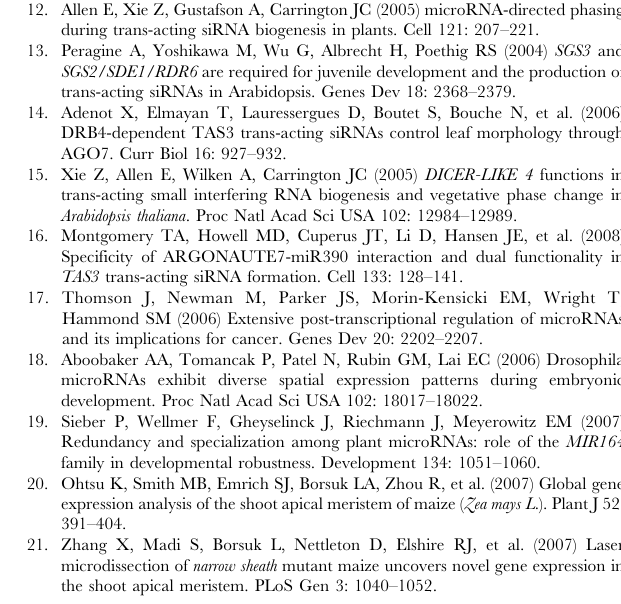
Figure S3 Diagrams showing the sequences and secondary structure of the mir390a (A) and mir390b (B) precursor stem-loops. Blue lines mark the mature miR390 sequence. Found at: doi:10.1371/journal.pgen.1000320.s003 (0.17 MB JPG) Figure S4 Phylogenetic analysis of DICER-LIKE (DCL) proteins from maize, rice and Arabidopsis identifies a single conserved maize DCL1 protein. (A) Un-rooted phylogram of Arabidopsis (At), rice (Os) and maize (Zm) DICER-LIKE proteins. Four sub-groups comprising DCL1, DCL2, DCL3 and DCL4 homologs are distinguished within the phylogenetic tree. The phylogram was generated as a consensus of 1000 bootstrap replicates by the neighbor joining method using the MEGA2 software. The scale bar indicates the relative frequency of changes along the branches. At least five dcl genes have been identified in maize; two most similar to Arabidopsis DCL3 and one each most similar to DCL1 , DCL2 , and DCL4 . Protein sequences were retrieved from the chromatin database (http://www.chromdb. org). (B) ZmDCL1 (bold in A) contains conserved domains characteristic of the DCL proteins belonging to the Arabidopsis DCL1 sub-group. Protein domains were predicted using Pfam (http://pfam.wustl.edu/). Found at: doi:10.1371/journal.pgen.1000320.s004 (0.28 MB JPG) Table S1 Sequences of primers used in this